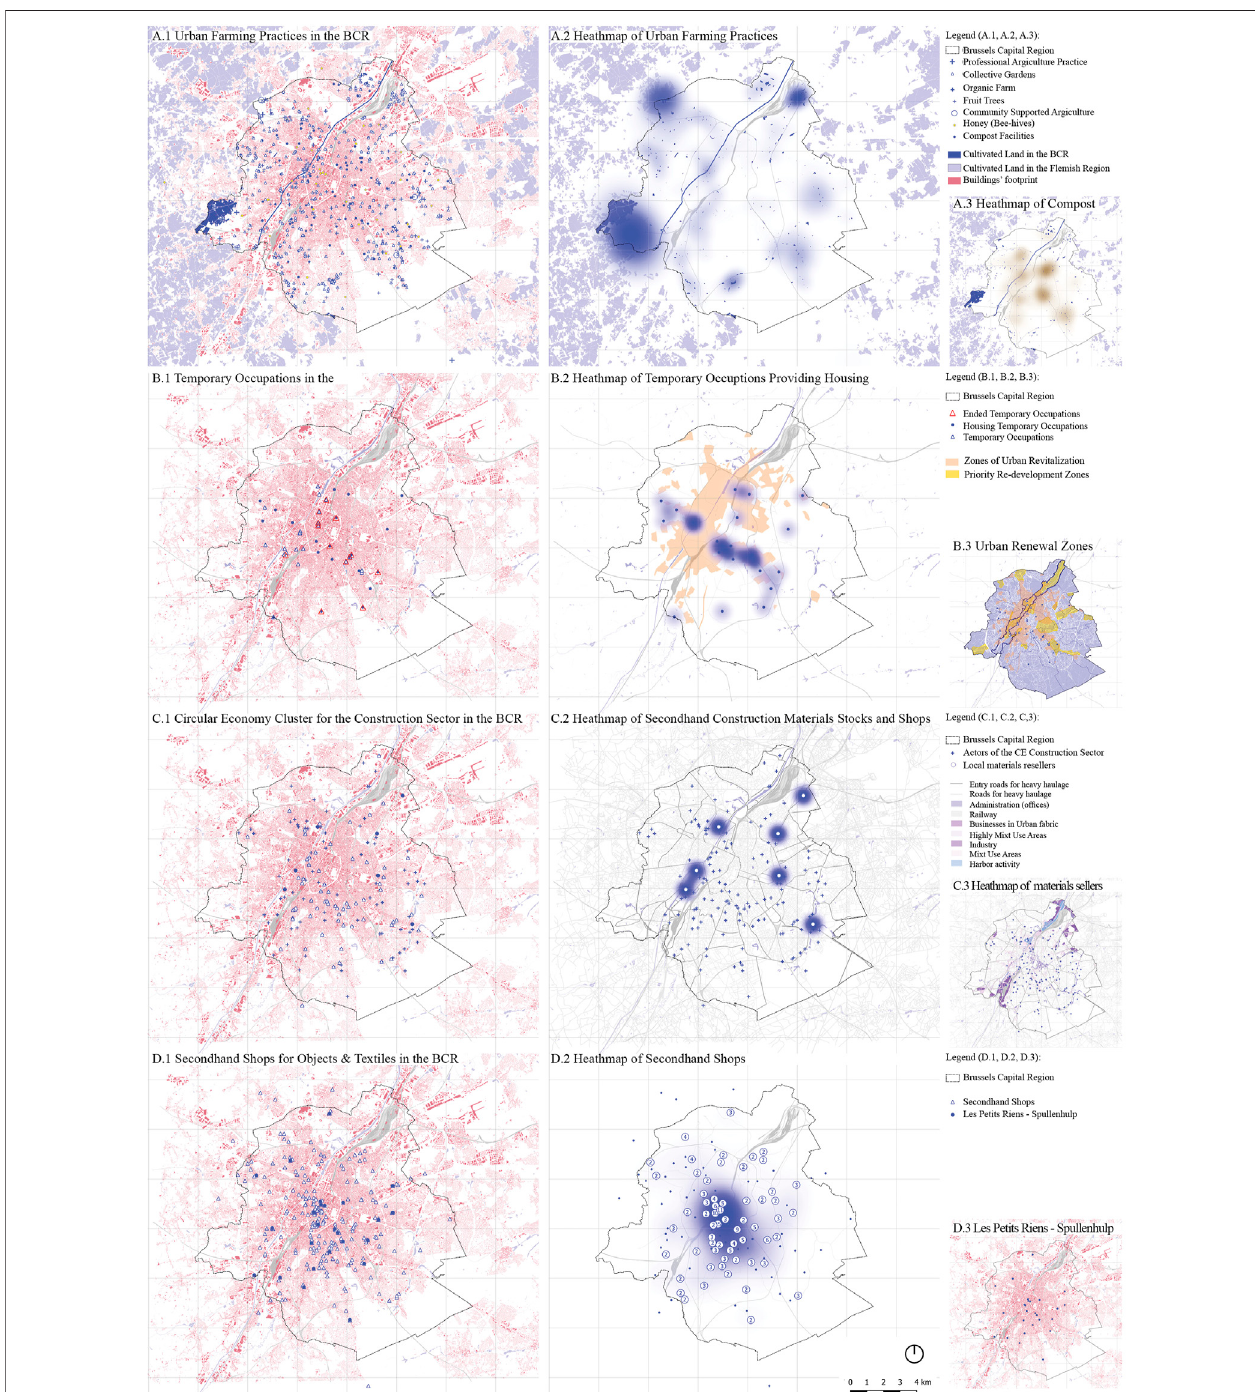
FIGURE 3 | Extract of the atlas of urban circularity practices in the Brussels Capital Region, by the authors.